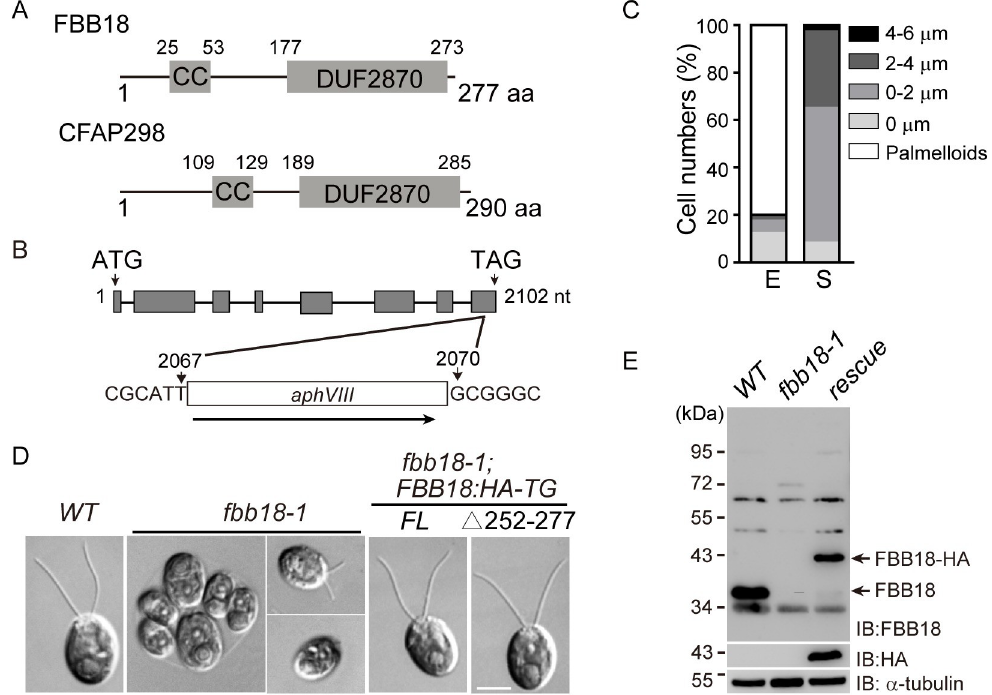
Fig 1. Isolation and characterization of an fbb18 mutant. (A) Diagrams showing the domain structures of FBB18 and its human counterpart CFAP298. The numbers indicate the positions of the residues. CC, coiled-coil domain. (B) Schematic illustration of the FBB18 gene shows the insertion of a foreign DNA fragment containing paromomycin resistance gene aphVIII . The insertion was identified by PCR and DNA sequencing. Grey box, exon; line, intron; numbers, nucleotide positions. (C) Ciliary phenotypes of fbb18-1 grown in exponential (E) and stationary (S) growth phases. (D) DIC cell images show the ciliary phenotype of wild-type ( WT ), fbb18-1 , transformants expressing full-length ( FL ) or truncated ( Δ 252–277) gene. Bar, 5 μ m. (E) Immunoblot analysis of wild-type ( WT ), fbb18-1 and rescued cells expressing FBB18 : HA-TG with the indicated primary